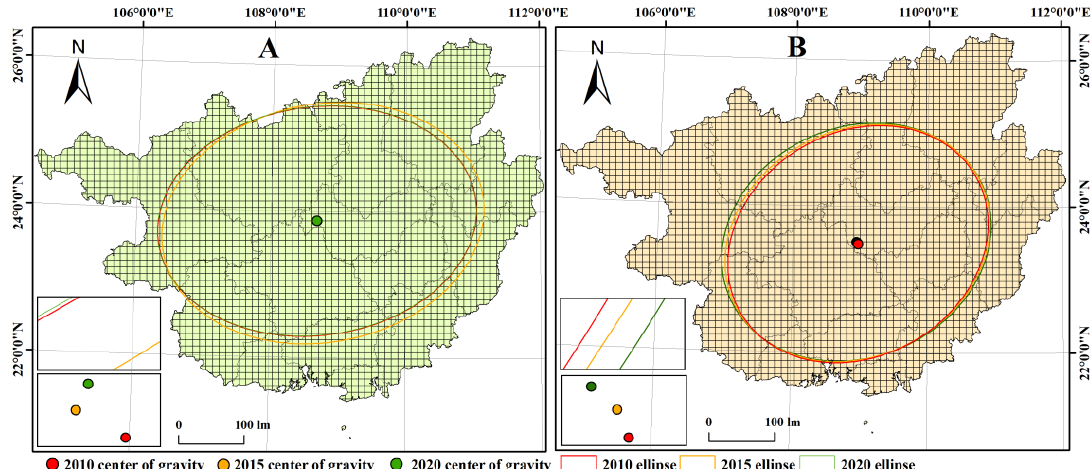
Figure 8. Elliptical variation of standard deviation of ecological-economic values. (Note: ( A ) is eco- logical value, ( B ) is economic value.)